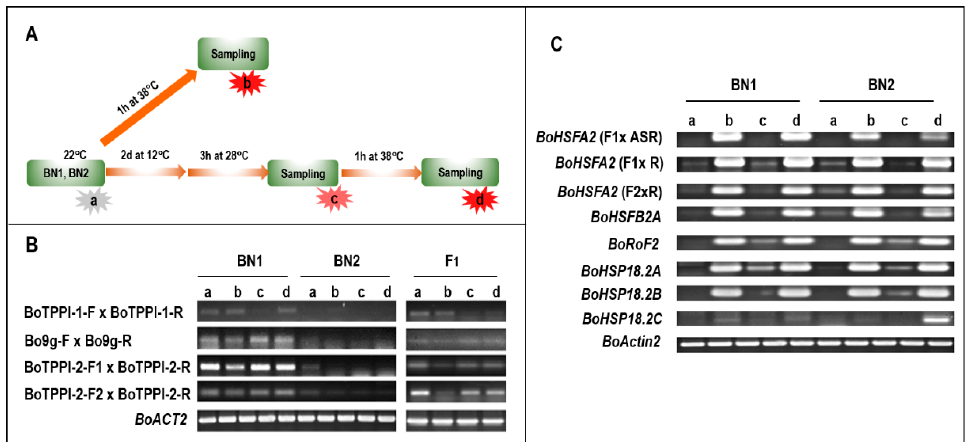
Figure 6. Expression of BoTPPI genes and selected heat shock-related genes in cabbage genotypes. ( A ) Temperature treatments such as heat shock (b), warming (c), and heat shock after warming (d). ( B ) Expression of BoTPPI-1 and BoTPPI-2 in BN1 and BN2 inbred lines and their F 1 hybrid. ( C ) Expression of heat shock (HS)-related genes in BN1 and BN2 inbred lines.